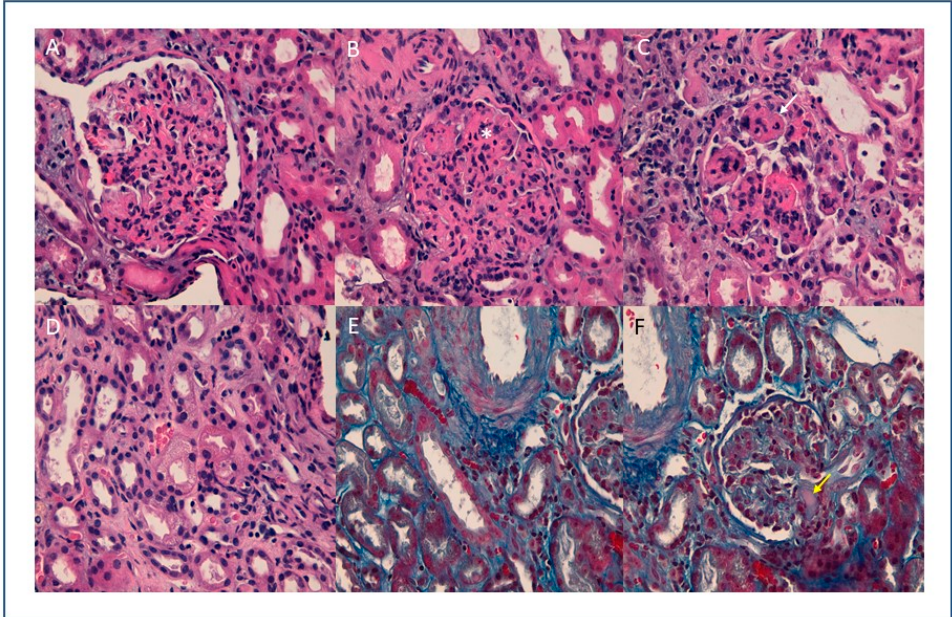
Figure 1. ( A ) (10 × ) ( B ) (20 × ) ( C ) (40 × ) H.E: Glomeruli with endocapillary proliferation, observing collapsed vascular lumens and increased cellularity with isolated neutrophils (white arrow) and nuclear fragments (*). Thrombi are not observed; ( D ) (20 × ), HE: Tubules with isometric cytoplasmic vacuolization, ( E ) (10 × ) ( F ) (40 × ) Trichrome stain: erythrocytes in peritubular capillaries and solitary glomerular hyaline thrombus (yellow arrow).